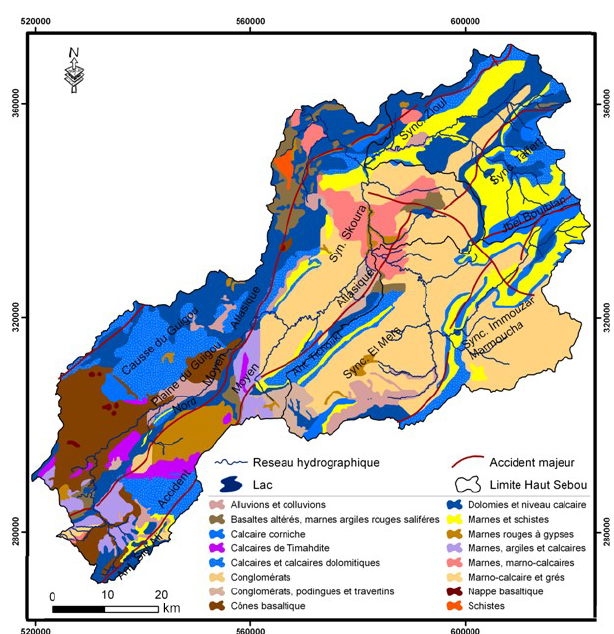
Figure 2. Lithologie du bassin du